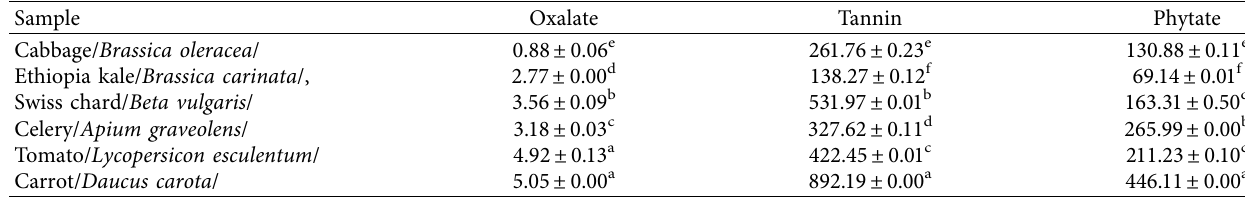
Table 3: Antinutrient content (mg/100g, dwb) of composite vegetable samples.